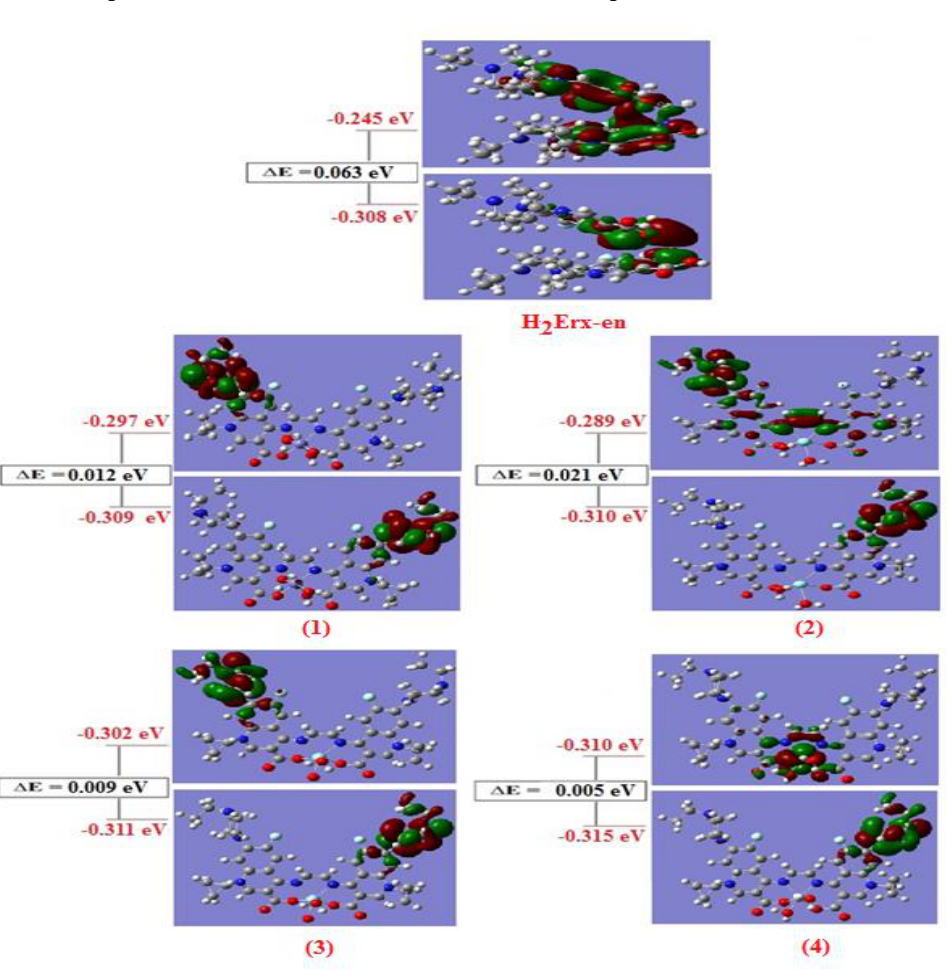
Figure 4. Molecular orbital surfaces and energy levels of studied complexes by using DFT calculations.